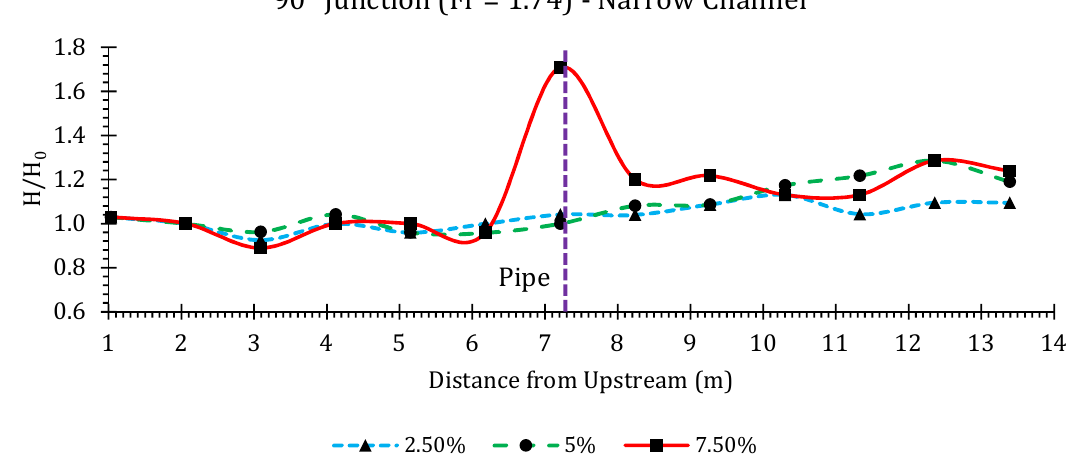
Figure A33. Water height ratios in a 90° junction for Fr = 1.74 in the narrow channel.